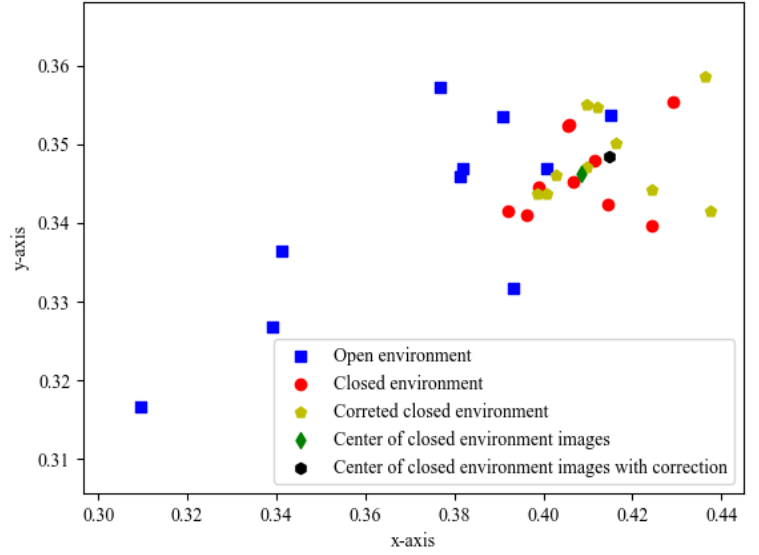
Figure 13. Distribution of the color central of the tongue images captured in the open and closed environment. Table 9. Average coordinates and their variances of image centers for three groups of images. X mean Y mean X var Y var Open